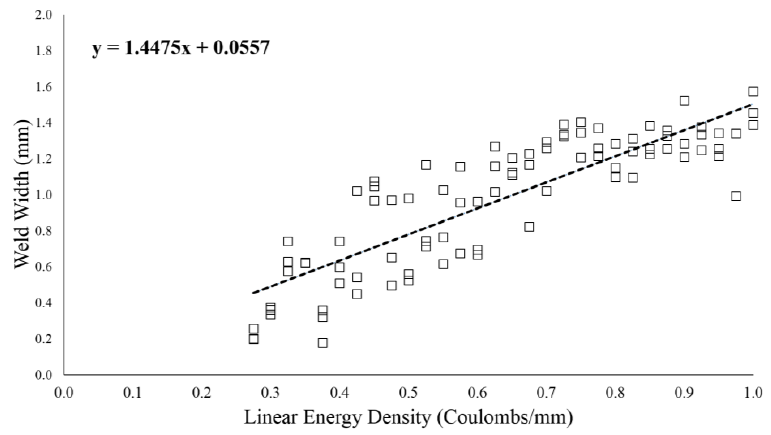
Figure 7. Weld width as a function of linear energy density for 20 mm/s on two layers of LLDPE.